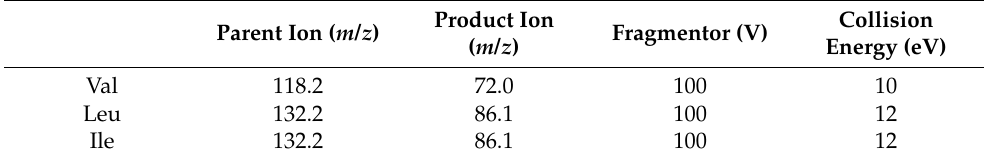
Table 4. Selected parent-product ion m / z transitions and MS conditions used for BCAAs quantifica-